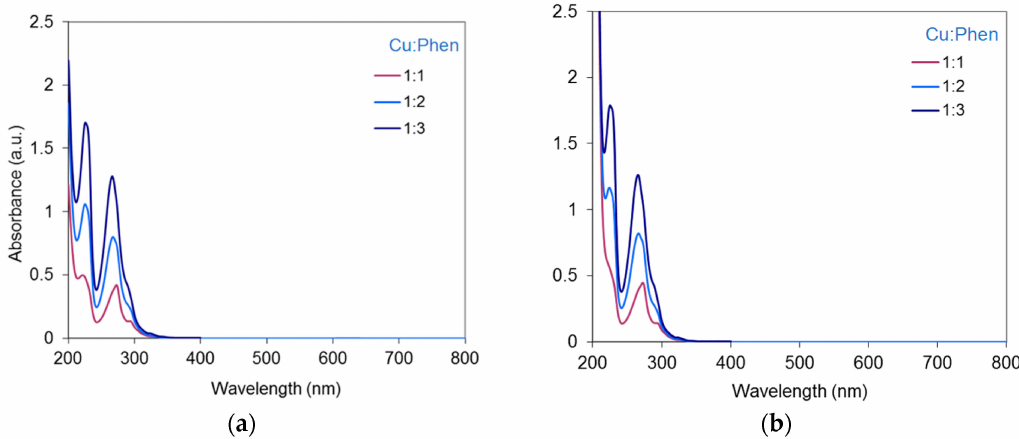
Figure 7. Absorbance spectra of the Cu-Phen solutions at ( a ) pH 10.7 and ( b ) pH 12.3, with Cu:Phen molar ratio = 1:1, 1:2 and 1:3, and [Cu] = 15 µ M.